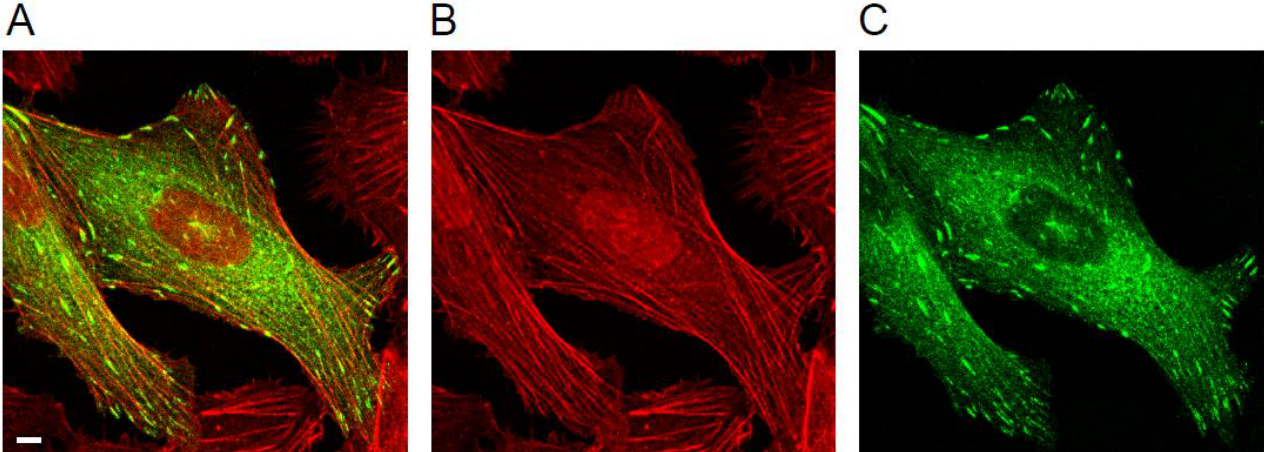
Figure 1. Focal adhesions (FAs) and stress fibres. ( A ) Overlay of the maximum projection of the confocal image of a U2OS cell stably expressing the intracellular FA protein paxillin-GFP (green) and stained with phalloidin-CF405 (pseudocolour red), a toxin that specifically binds to F-actin such as the stress fibres connecting to FAs. Note that the other FA proteins discussed here show identical distributions at confocal resolution. Scale bar: 5 µm ( B ) phalloidin channel of the data shown in ( A ). ( C ) GFP-channel of the data shown in ( A ).